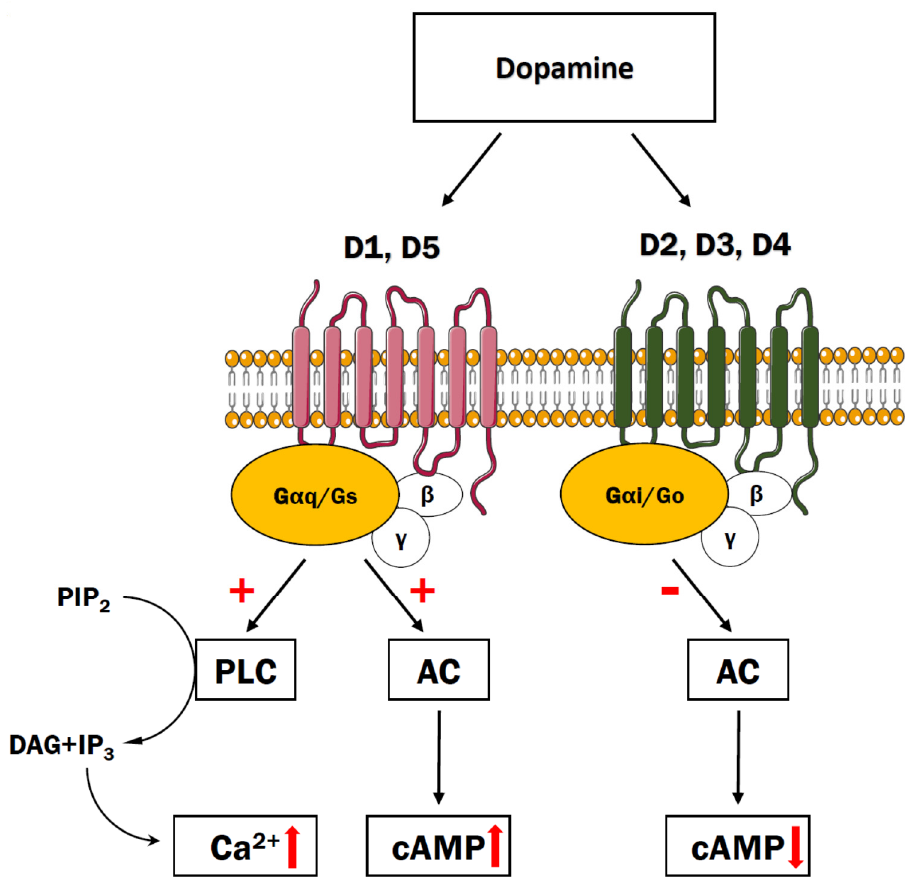
Figure 2. The dopamine system. Binding of dopamine to D1 or D5 receptors activates PLC signaling pathway that triggers Ca 2+ release from the cisterns of endoplasmic reticulum and has a stimulatory effect on adenylyl cyclase that induces cAMP increase. When acting through D2, D3, or D4 receptors, dopamine exerts an inhibitory effect toward adenylyl cyclase leading to decrease in intracellular cAMP.